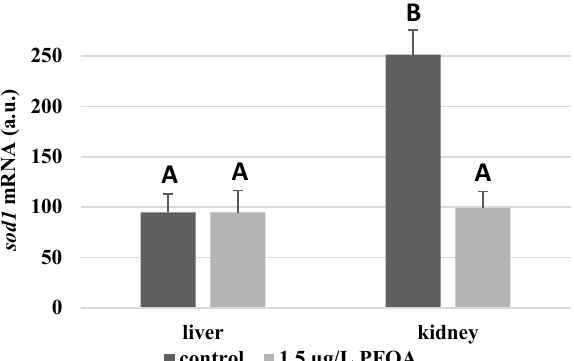
Figure 1. sod1 mRNA expression levels in the liver and kidney of T. newnesi exposed to PFOA and unexposed (the control group). Values (arbitrary units) are indicated as mean ± SD. Transcription levels were normalized to the gapdh housekeeping gene. Different letters correspond to significant statistical differences ( p < 0.05) among different means (Student–Newman–Keuls test), with ten specimens per experimental group.